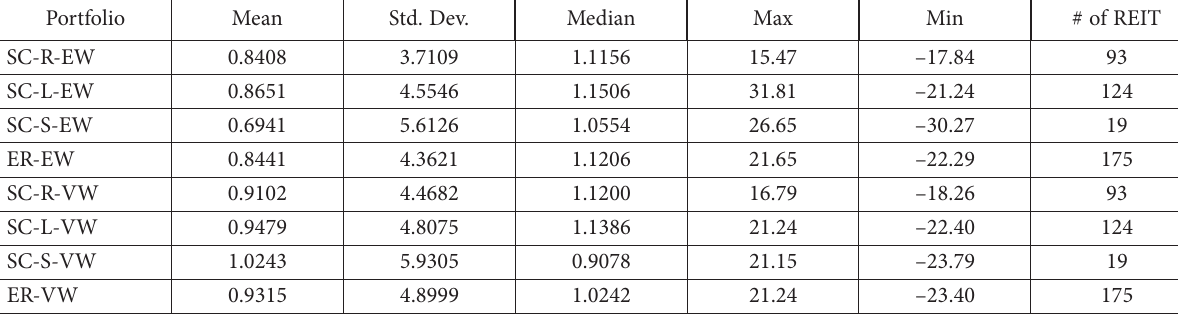
Table 1. Descriptive statistics for returns (%) of constructed portfolios